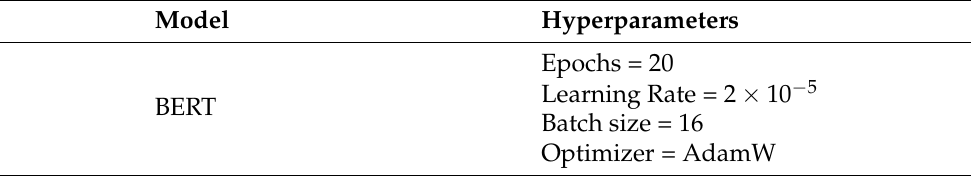
Table 2. Hyperparameters configuration for the BERT